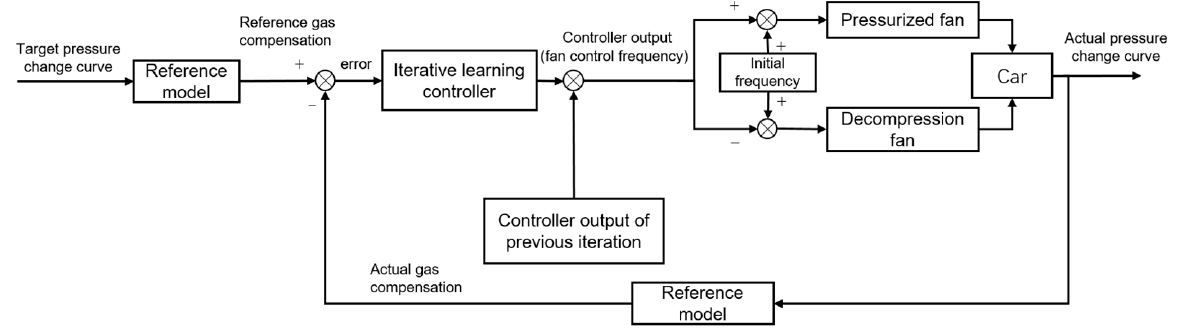
Figure 8. A ‐ ILC system for the air pressure compensation system. Figure 8. A-ILC system for the air pressure compensation